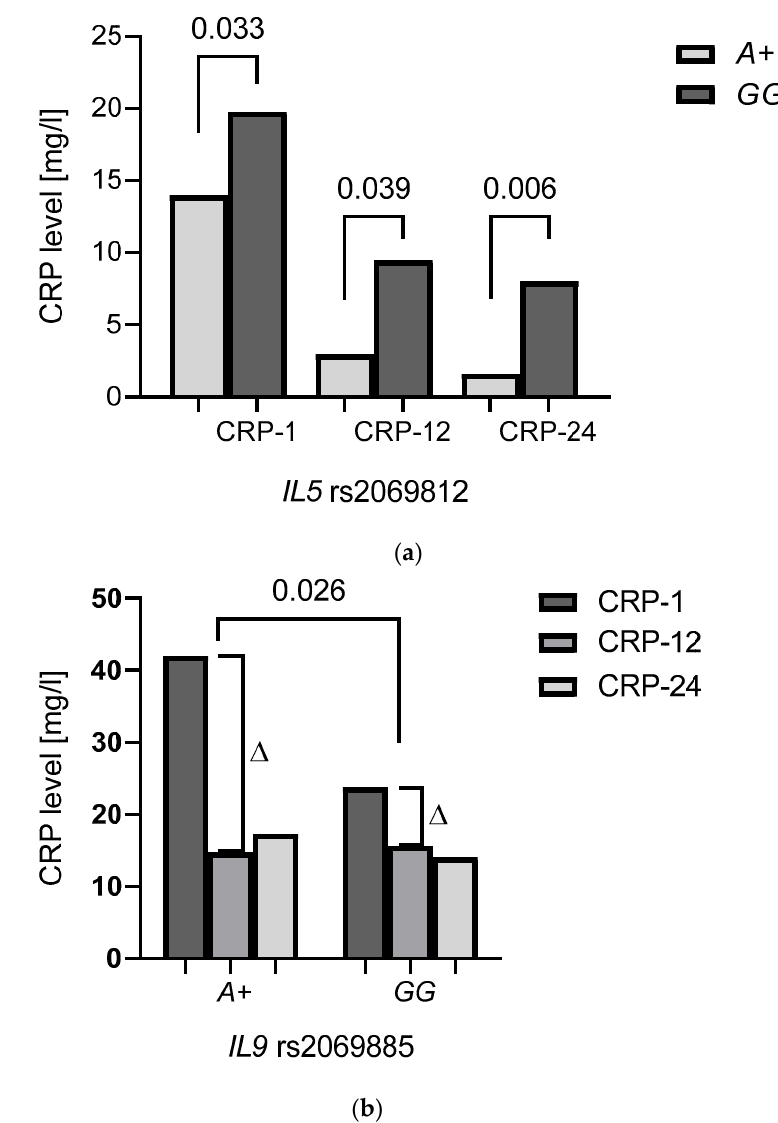
Figure 3. Relationships between the IL5 rs2069812 ( a ) and IL9 rs2069885 ( b ) and the CRP values in AS patients during anti-TNF treatment . A+ — A allele carriers ( AG / AA genotypes); GG— carriers of GG genotypes; CRP-1—at the baseline; CRP-12—after 12 weeks of anti-TNF therapy; CRP-24—after 24 weeks of anti-TNF therapy; Δ — changes in CRP levels after 12 weeks of anti-TNF therapy compared to baseline.